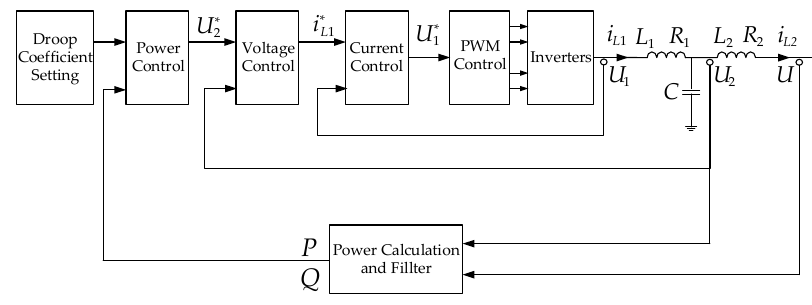
Figure 1. Control and interface block diagram of IIDG.